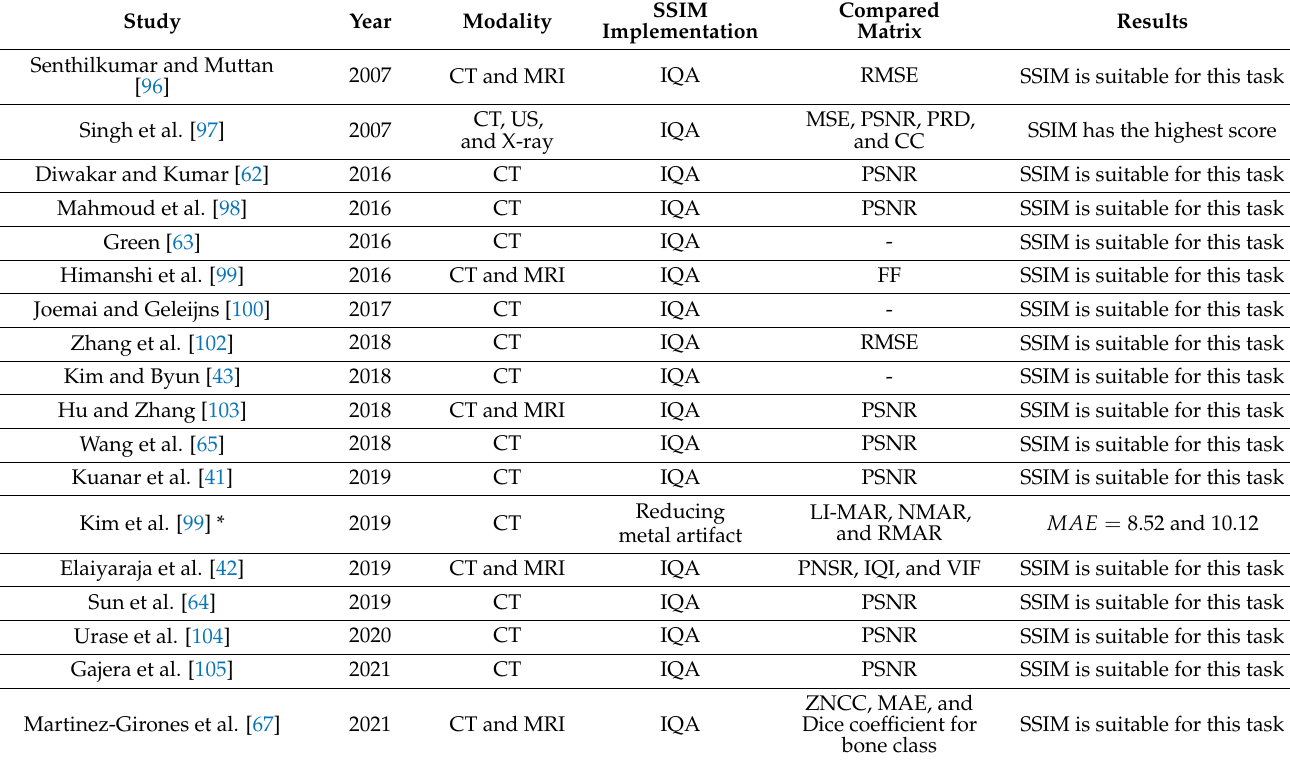
Table 2. Summary of the published articles encompassing SSIM for CT. CT, computed tomography; MRI, magnetic resonance imaging; RMSE, root-mean-square error; MSE, mean-square error; PSNR, peak-signal-to-noise ratio; PRD, percent rate of distortion; CC, correlation coefficient; FF, fusion factor; LI-MAR, linear interpolation metal artifact reduction; NMAR, normalized metal artifact reduction; RMAR, refined metal artifact reduction; IQI, image quality index; VIF, visual information fidelity; ZNCC, zero-normalized cross-correlation; MAE, mean-absolute